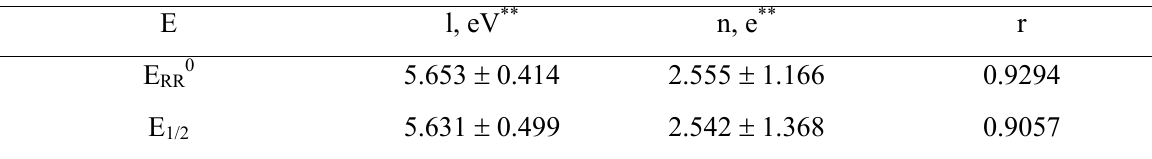
Table 1d. Correlations of A values with standard potentials of reductive dimerization (E RR0 ) and with titration by sodium sulphite [7, 8] (m = 7) * .